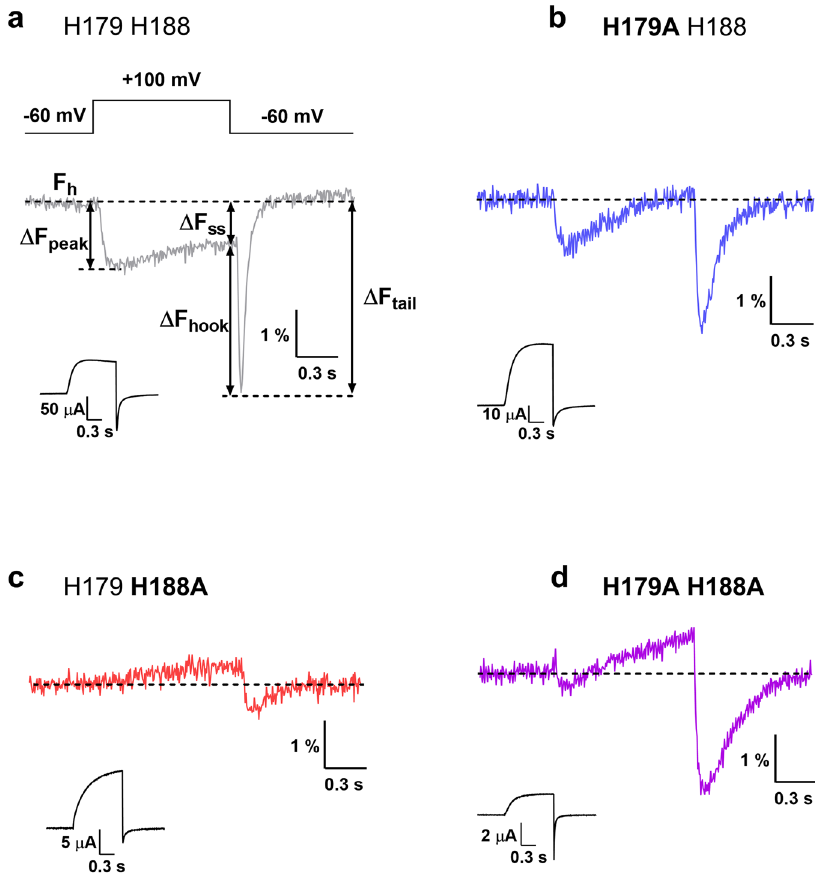
Fig. 1 Fluorescence traces of CiHv1-E241C and alanine mutants. Representative fl uorescence responses and proton currents to a voltage step from − 60 mV to + 100 mV recorded from oocytes expressing Ci-Hv1 channels labeled with TAMRA-MTS at the E241C position ( a ) and different alanine mutants: H179A ( b ), H188A ( c ) and H179A H188A ( d ). F h is the fl uorescence at the holding voltage of − 60 mV, Δ F peak is negative peak fl uorescence change during the voltage step, Δ F ss (steady state) is change in fl uorescence at the end of the voltage step, Δ F tail is maximum change in fl uorescence during repolarization after the voltage step and Δ F hook = Δ F tail – Δ F ss . The insets show the measured proton current for the corresponding construct. Representative fl uorescence traces were selected from N measurements: ( a ) N = 72, ( b ) N = 13, ( c ) N = 8, ( d ) N =